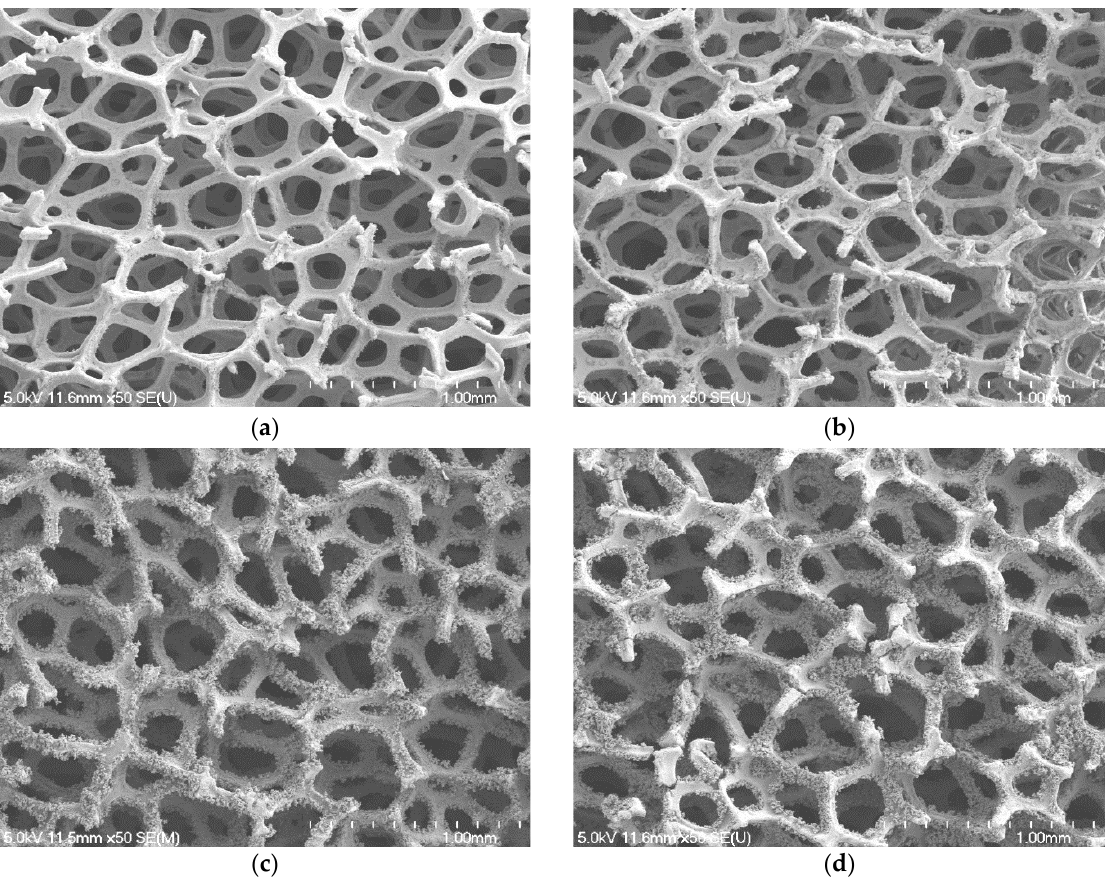
Figure 3. SEM images of blackening copper foam at 50 magnifications: ( a ) 1.5 mol/L; ( b ) 2.5 mol/L; ( c ) 3.5 mol/L; ( d ) 4.5 mol/L.